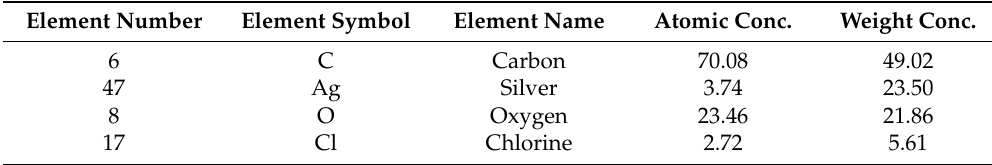
Table 1. Elemental composition of the synthesized AgNPs.